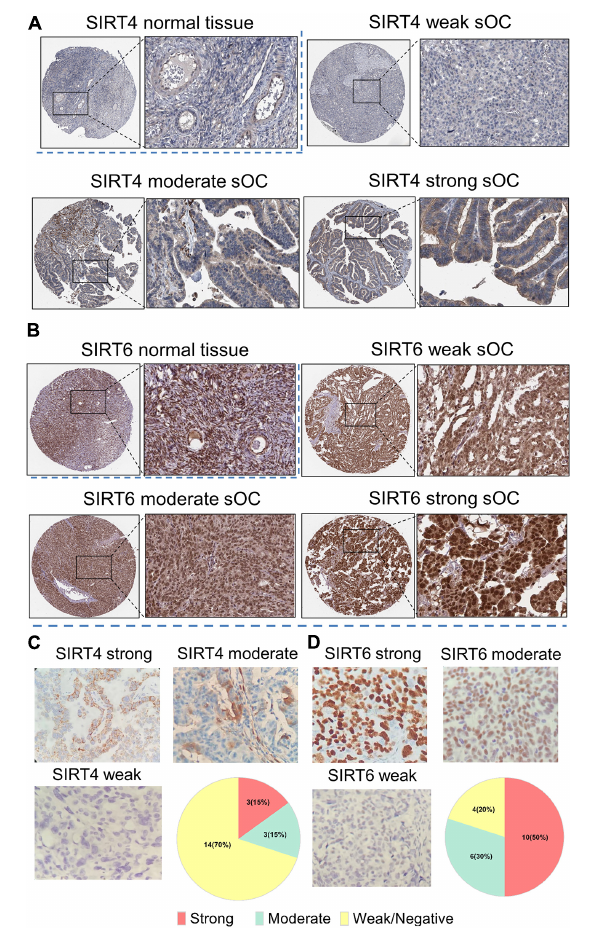
FIGURE 10 | Immunohistochemistry of SIRT4 and SIRT6 in samples from normal ovaries and serous ovarian cancer patients (sOC). (A,B) Image in the upper left panel is for the SIRT4/SIRT6 staining intensity of normal ovary tissues. Images in the rest of the panel are representative pictures of SIRT4/SIRT6 staining with an intensity from weak to strong. Black rectangle indicates the zoomed-in zone in the image. (C) Panel of SIRT4 immunohistochemical (IHC) staining pattern. Upper left , strong; upper right , moderate; lower left , weak or negative; lower right , pie chart of the indicated case numbers (total n = 20). (D) Panel of SIRT6 IHC staining pattern. Upper left , strong; upper right , moderate; lower left , weak or negative; lower right , pie chart of the indicated case numbers (total n =